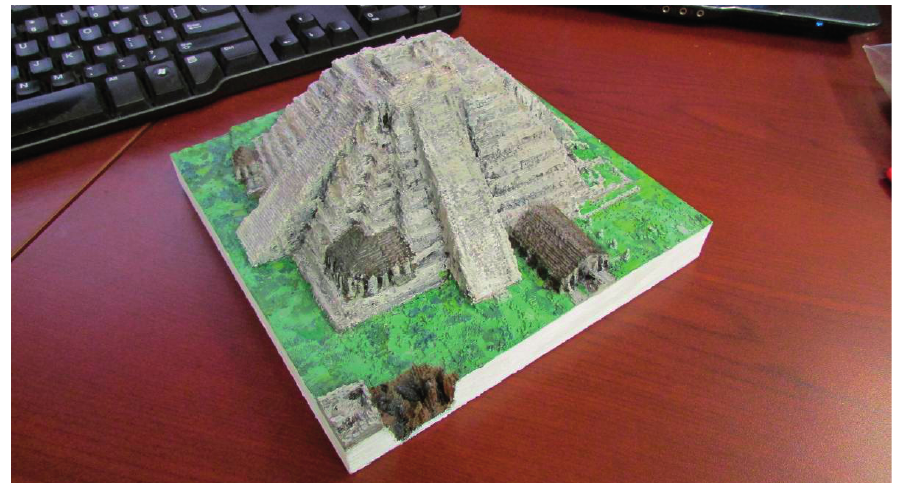
Figure 24. Photo of a plastic 3D print of the main Pyramid in